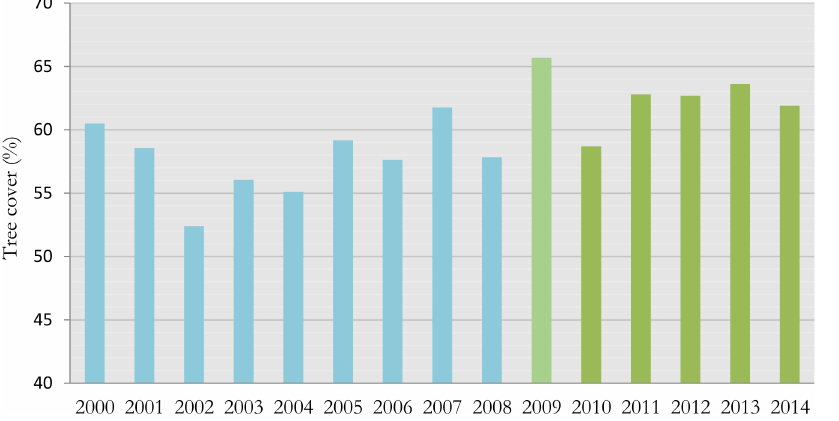
Fig 1. Comparison of mean VCF tree-cover in the study area between the pre-PES period (blue) and during the PES period (green).